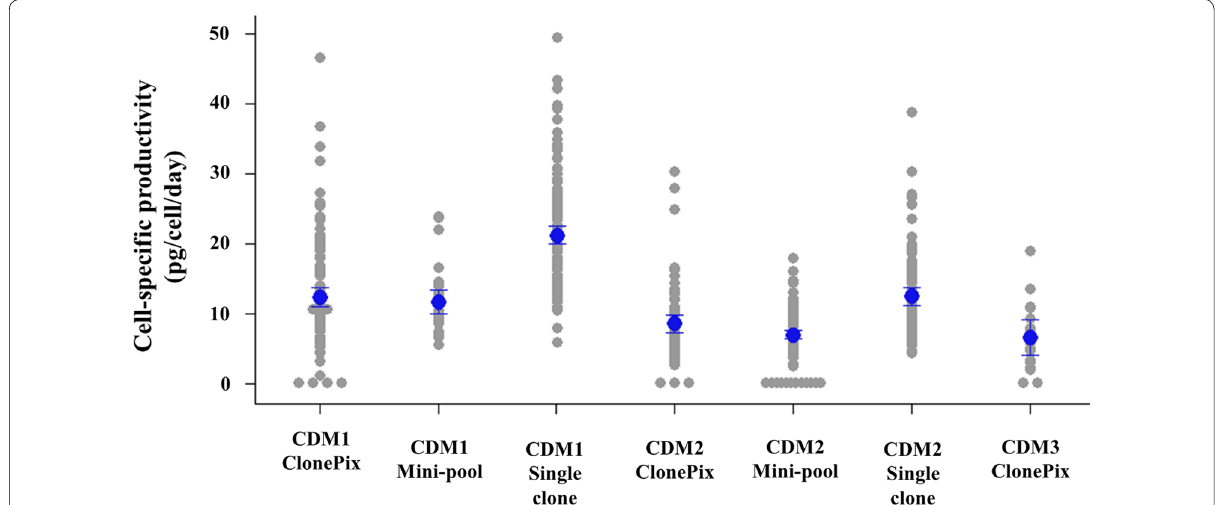
Fig. 3 Cell-specific productivity from 6-well